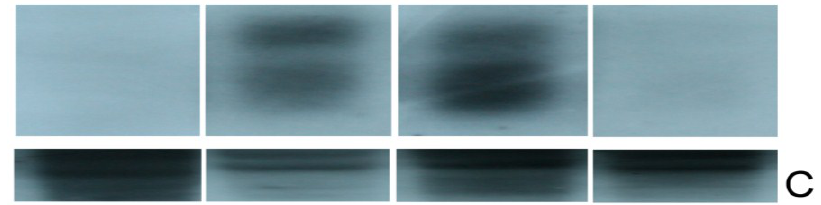
Figure 2. Identification of local suppressors in the genome of PMWaV-2. ( A ) WT. N. benthamiana plants were co-infiltrated with cultures of Agrobacterium carrying 35S-sGFP and Agrobacterium carrying individual constructs. Infiltrated leaves were examined under short-wavelength UV light and photographed with a Nikon 5000 digital camera at 5 days post-infiltration (dpi). Leaves co-infiltrated with 35S-GFP and pBIC-35S-empty vector (EV) or 35S-GFP with Tomato bushy stunt virus (TBSV)-35S p19 were used as negative or positive controls respectively. ( A ) shows fluorescence produced by the two identified local suppressors, p20 and CP. Northern blots of GFP mRNAs ( B ) and GFP siRNAs ( C ) from agroinfiltrated leaves at 5 dpi. Ethidium bromide staining of ribosomal RNA was used